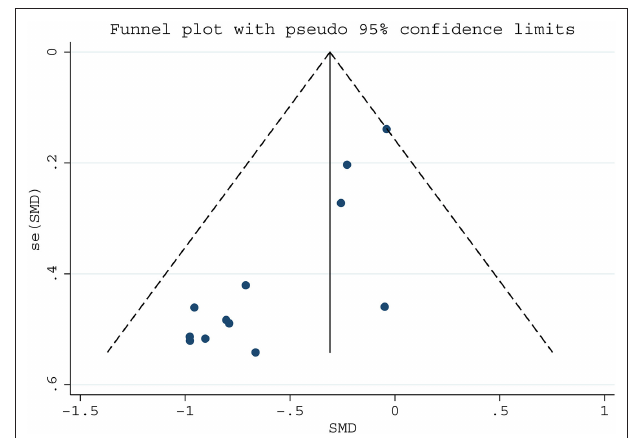
FIGURE 3 | Funnel plot for assessing publication bias for serum folate and lung cancer